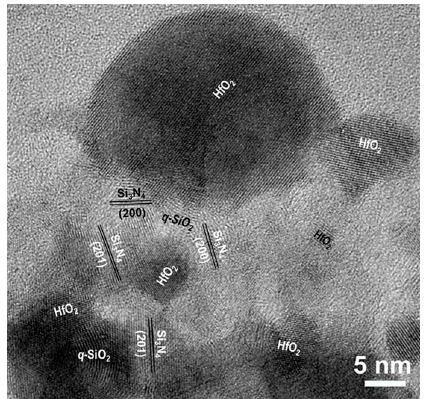
Figure 12. HRXTEM image of the oxide/transition layer interface in the annealed Hf 7 B 10 Si 32 C 2 N 44